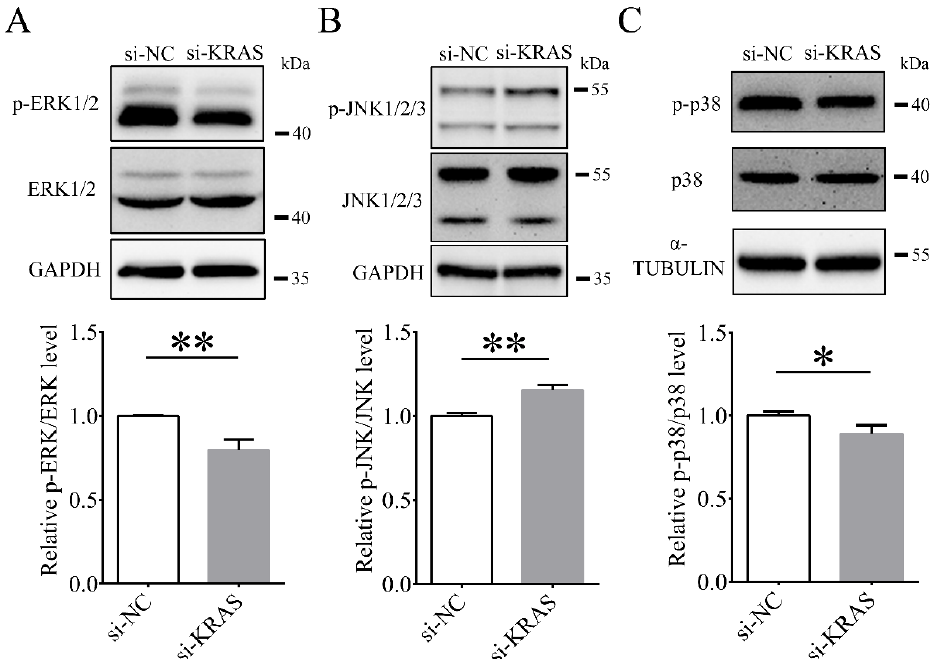
Figure 7. Effects of Kirsten rat sarcoma viral oncogene homolog (KRAS) on the phosphorylation levels of mitogen-activated protein kinases (MAPKs) in MAC-T cells. Representative Western blotting images and phosphorylated/total levels of extracellular regulated protein kinase 1/2 (ERK1/2, ( A )), c-Jun N-terminal kinase 1/2/3 (JNK1/2/3, ( B )), and p38 ( C ) in MAC-T cells with or without KRAS inhibition. The α -TUBULIN loading controls were performed for p-p38 and p38 on the same membrane. Significant differences are represented with * ( p < 0.05) and ** ( p < 0.01).